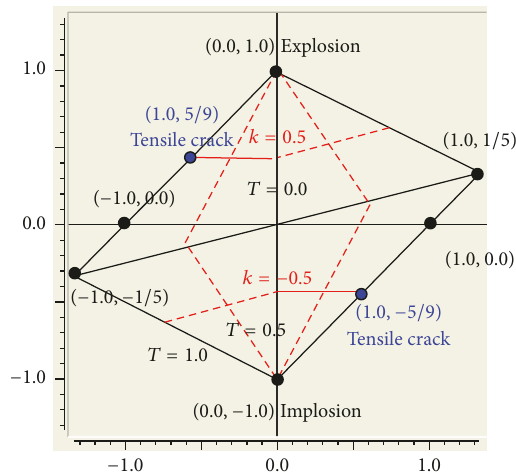
Figure 1: Hudson source plot indicating the regions for each